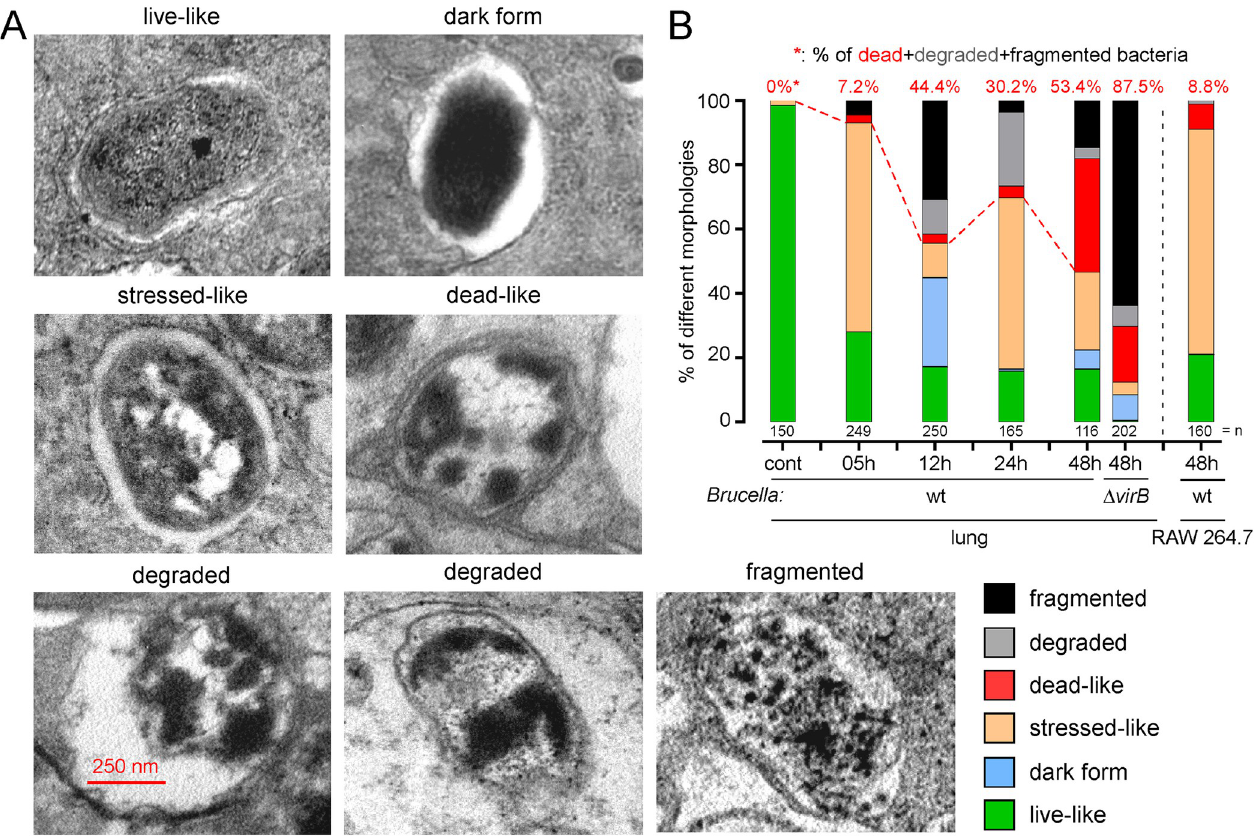
Fig 3. Transmission electron microscopic analysis of B . melitensis morphology inside alveolar macrophages purified from infected mice. C57BL/6 mice (n = 10) received intranasally PBS (uninfected mice) or 10 8 CFU of mCherry-expressing wild-type or Δ virB strains of B . melitensis and were sacrificed at the indicated time. Lungs were harvested at the indicated time (5, 12, 24, 48 hours post-infection) and alveolar macrophages were purified and analyzed by transmission electron microscopy as described in the Materials and Methods. RAW 264.7 macrophages were infected with an MOI of 50 (50 bacteria per cell on average) of an mCherry-expressing wild-type strain of B . melitensis , harvested at 48 hours post-infection and analyzed by transmission electron microscopy. Data shown are ( A ) representative images of bacteria from alveolar macrophages displaying live-like, dark, stressed-like, dead-like, degraded and fragmented morphologies, ( B ) the frequency of each bacterial morphology observed in each condition (n indicates the number of infected cells observed per condition). These results are representative of two independent experiments.